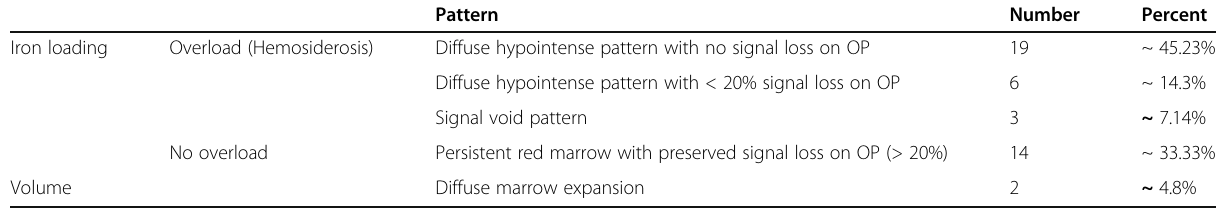
Table 1 Diffuse bone marrow changes in SCD ( n =